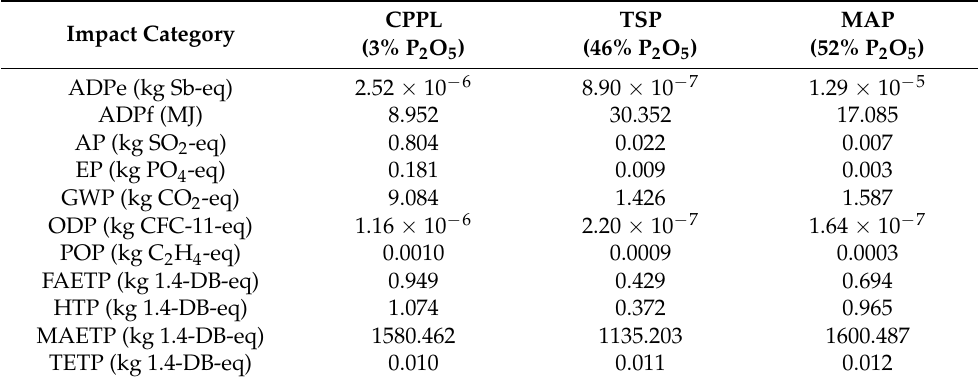
Table 9. Impact assessment of the production of 1 kg of phosphate